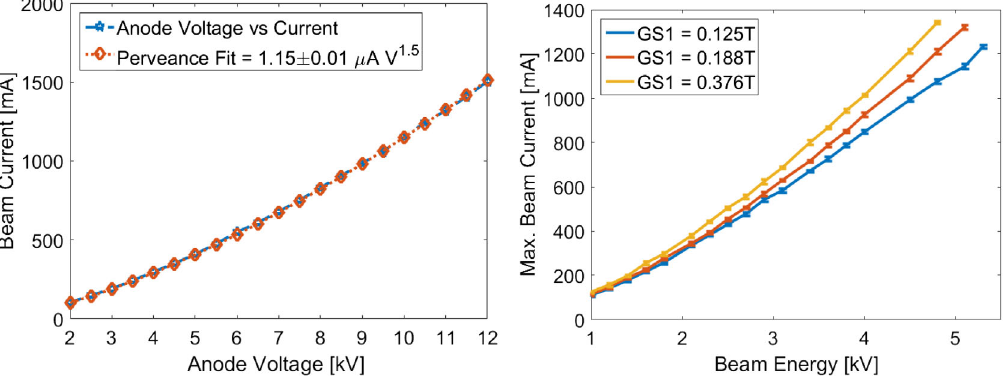
FIG. 3. Electron gun perveance measurement for a hollow electron beam (left) and measurement of drift space perveance with different GS1 magnetic fields